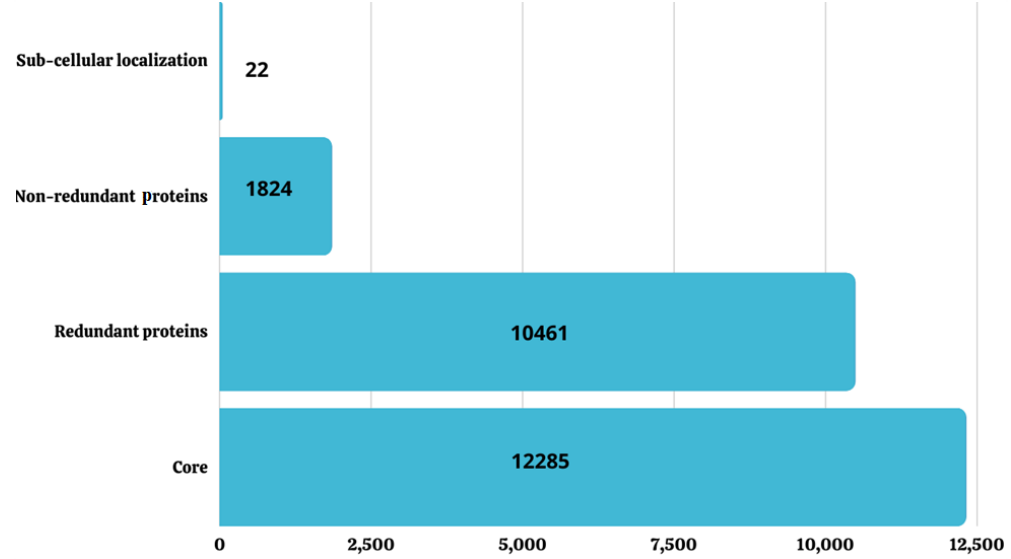
Figure 2. The overview of screening core proteins from different steps.